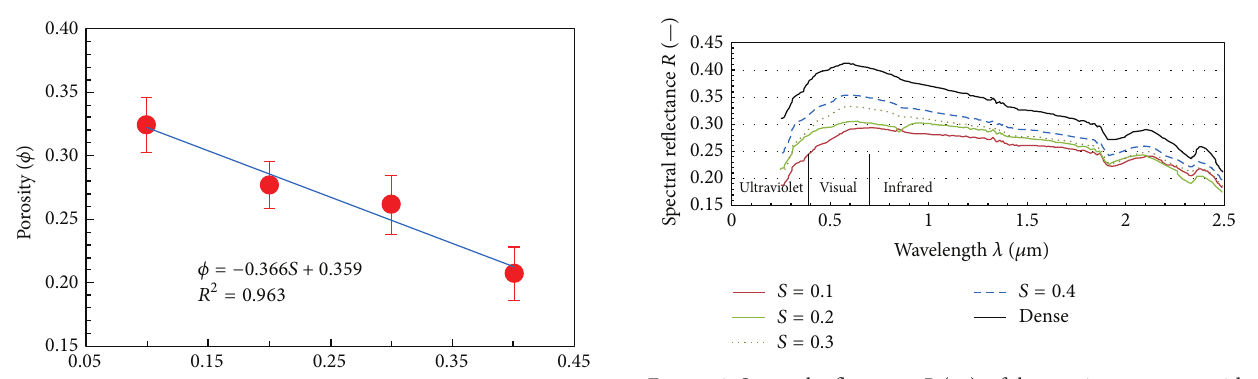
Figure 3: Spectral reflectance, 𝑅 (—), of the pervious concrete with different sand